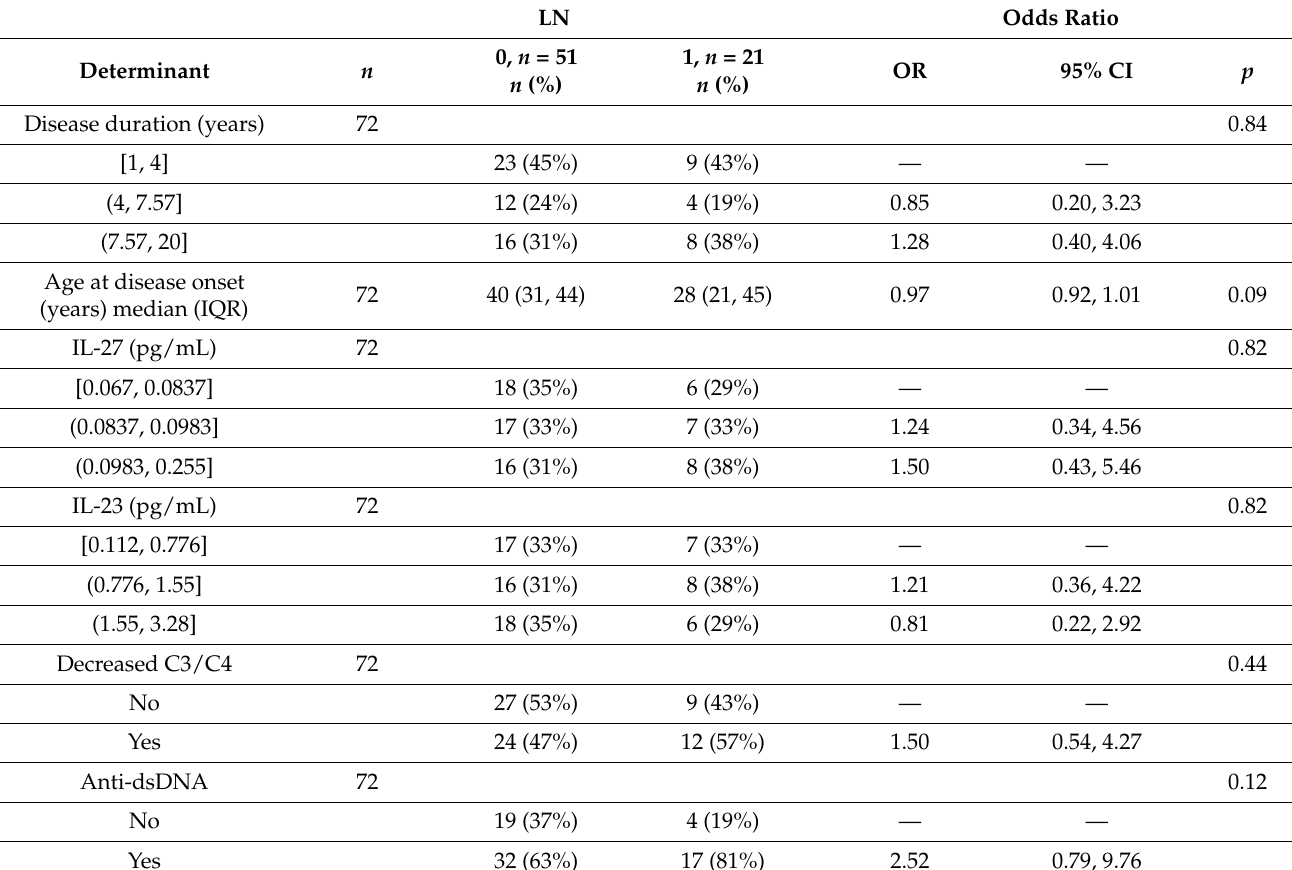
Table 4. Determinants of disease activity in a group of LN patients.